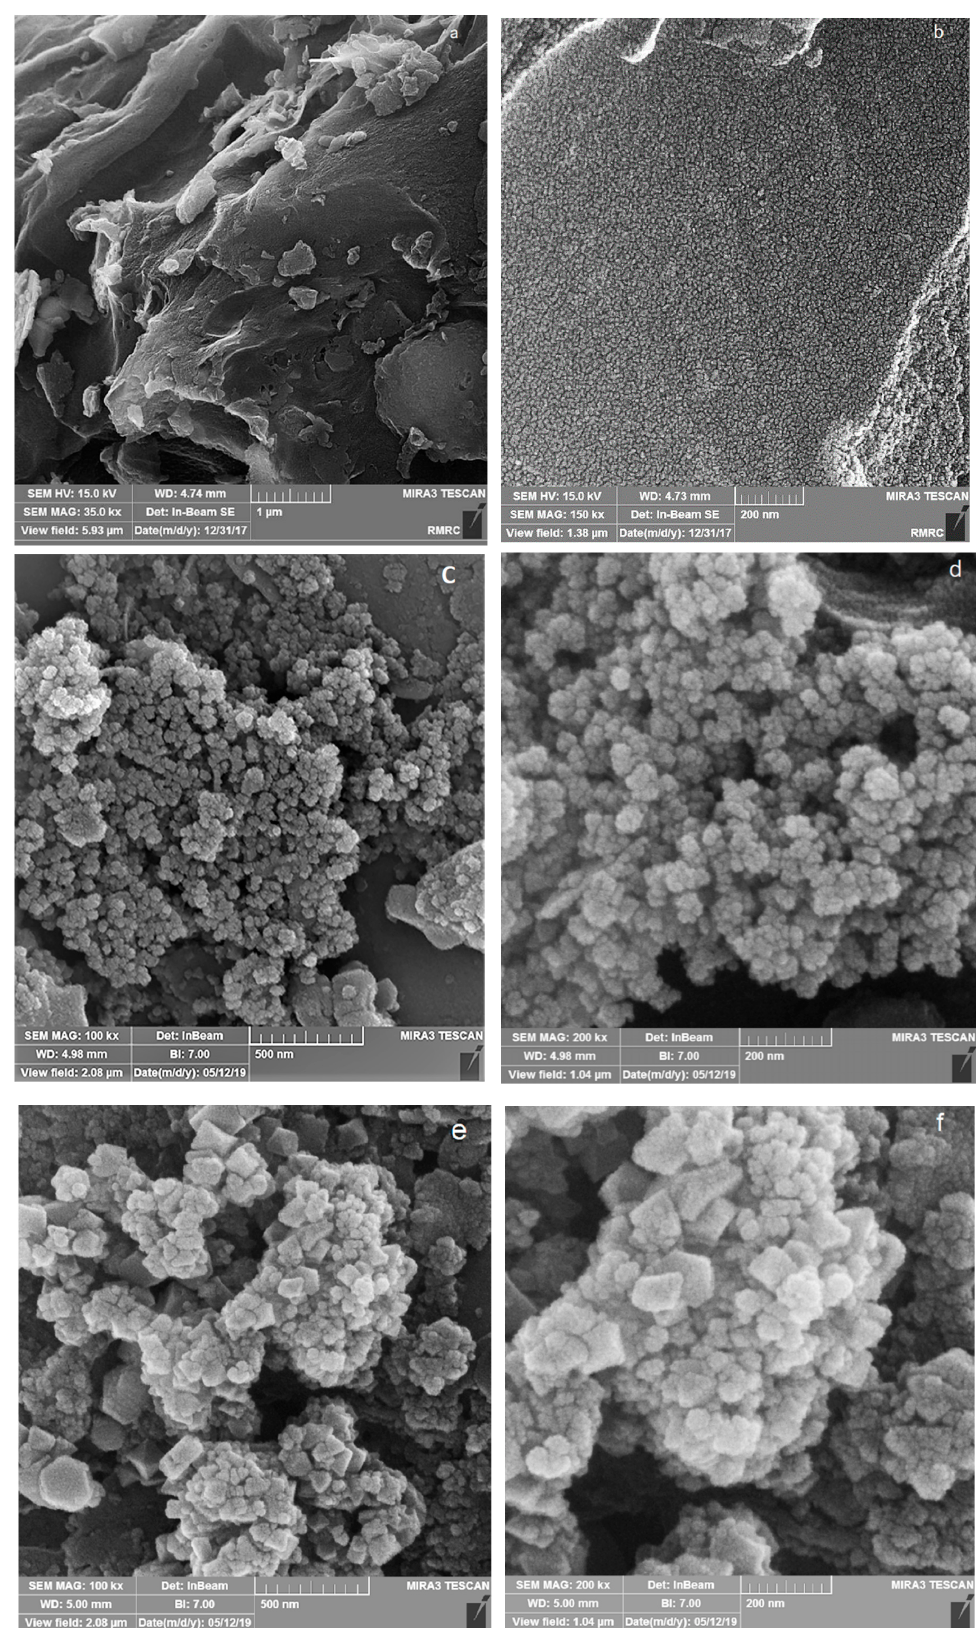
Figure 3. FESEM images ( a , b ) AC ( c , d ) Fe 3 O 4 @AC, and ( e , f ) MIL-100(Fe) @Fe 3 O 4 @AC.